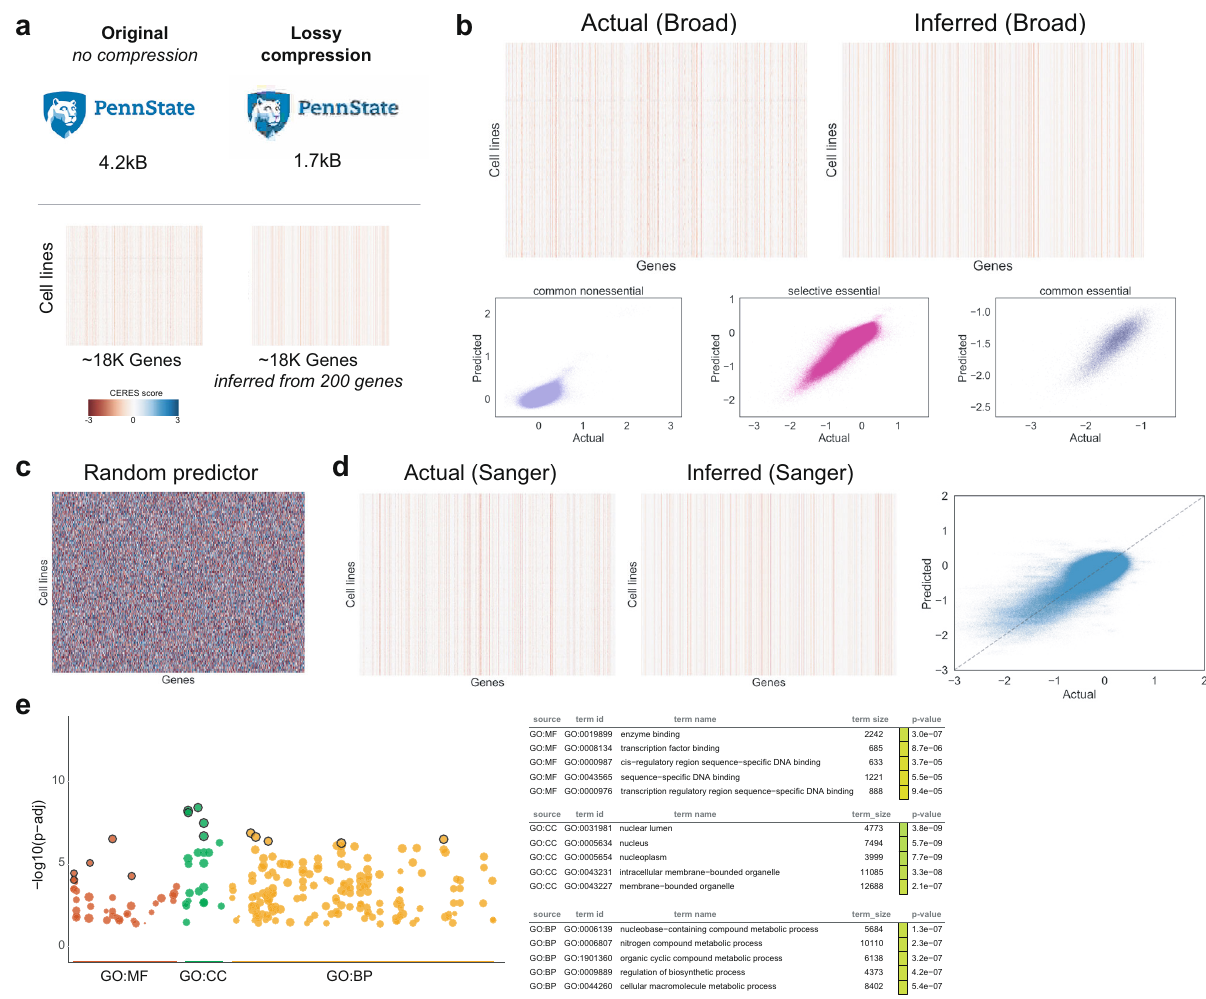
Fig. 5 Lossy genomic compression. a Schematic of lossy compression in terms of image compression using JPEG (top) and similarity to genomic loss-of- function compression. b Genome-wide comparison between actual and inferred CERES scores on a held-out test set, shown as heatmaps and scatter plots per gene essentiality classes. Models built based on only 200 lossy genes with their CERES scores as features. c The same test set as in ( b ) but was inferred based on a random predictor. d Genome-wide comparison between actual and inferred CERES scores on the independent test set data from the Sanger Institute. Multivariate models were trained based on Broad data from 19Q3 and used to predict independent cell lines and an independent library. e gpro fi ler2 plots identify functional enrichments in lossy compression sets. The P values are based on hypergeometric tests with multiple testing corrections using the g:SCS method. Source data are provided as a Source Data fi